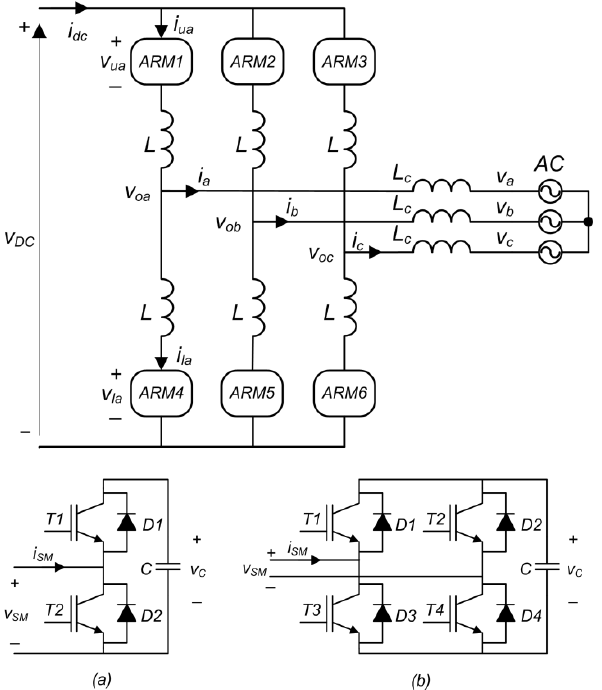
Figure 1. ( Top ) Topology of a modular multilevel converter (MMC) connected to the grid by means of an inductance. ( Bottom ) Switching modules (SM): ( a ) half-bridge (HB), and ( b ) full-bridge (FB) [21].